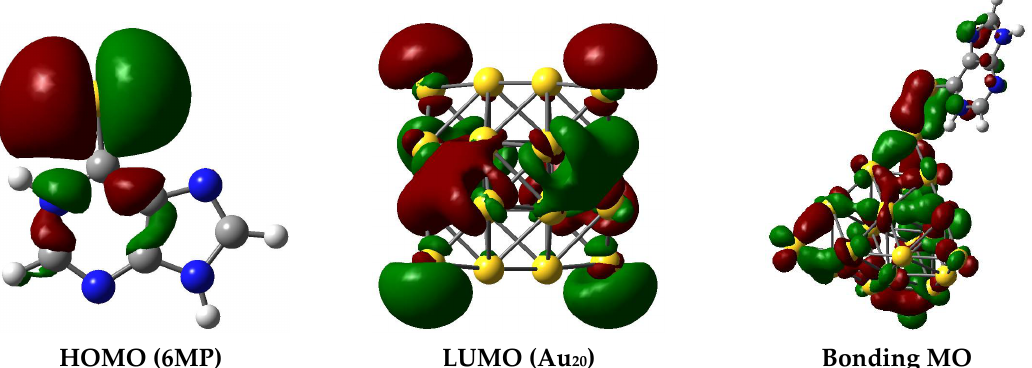
Figure 4. Shapes of frontier orbitals of the Au 20 cluster and 6MP molecule before and after interaction (Isovalue for the orbital rendering is 0.02 au).